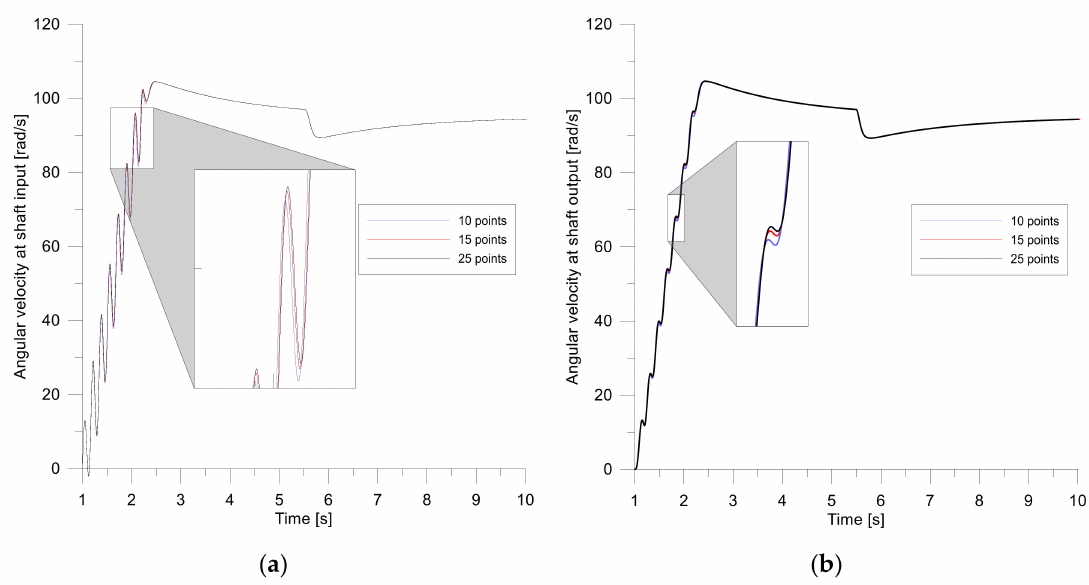
Figure 4. Angular velocity at shaft input ( a ) and output ( b ) vs. time.